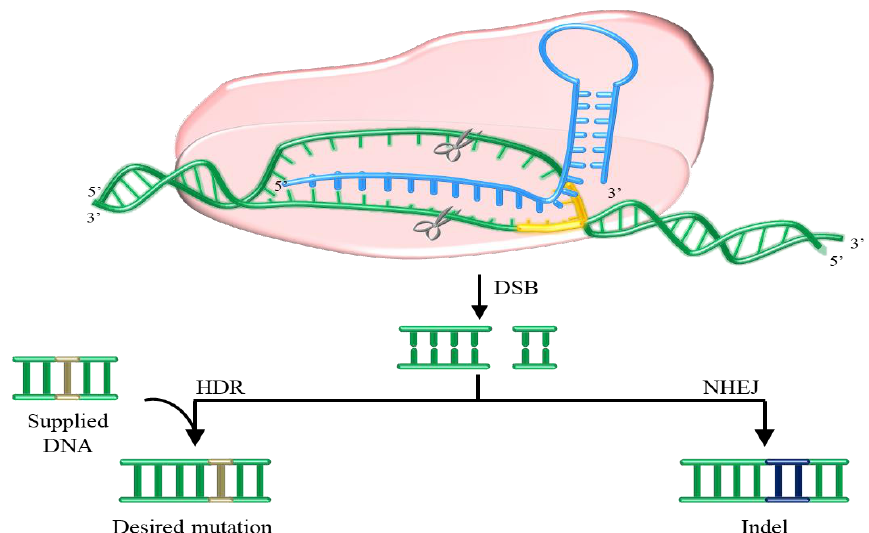
Figure 3. Scheme of the CRISPR / Cas9 editing mechanism. Cas9 protein (pink) and gRNA (light blue) get associated to the target DNA (green). By its nuclease activity, Cas9 produces a double-strand break (DSB) in the target sequence, guided by the PAM (protospacer adjacent motif, yellow). Then, the cell needs to repair the damage, by homologous direct repair (HDR) which can introduce controlled mutations by supplying a donor DNA, or by non-homologous end-joining (NHEJ), producing insertions or deletions (Indel).